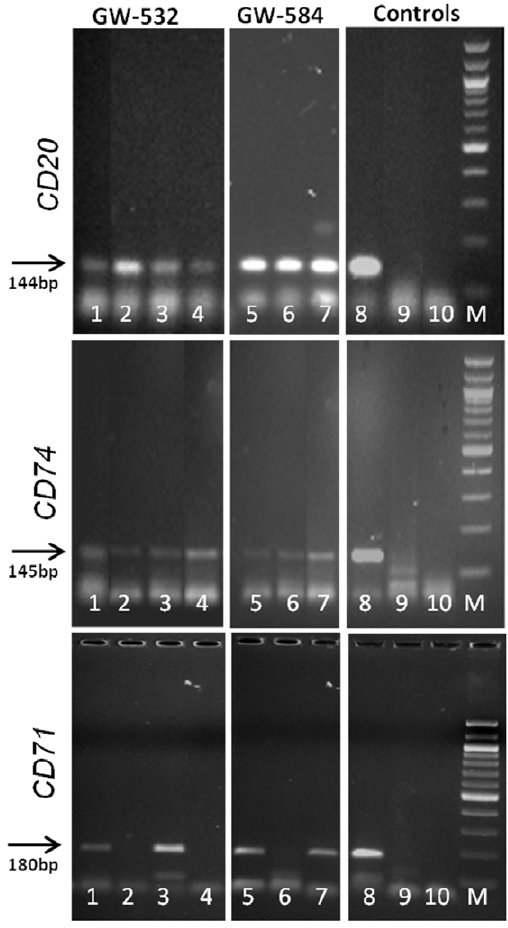
Figure 5. PCR evaluation of GW-532 and GW-584 for the presence of CD20 , CD74 , andCD71 genes. DNA was extracted from formalin-fixed, paraffin-embedded specimens to be used as templates for PCR amplification with primers, as described in Supporting Information Table S1. The individual panels demonstrate the presence or absence of each gene within several generations of xenografted tumors. For PCR of CD20 , the lanes contained GW-532 primary tumor (1), and xenograft tumors from generations 25 (2), 39 (3), and 115 (4); GW-584 xenografted tumors from generations 1 (5), 20 (6), and 57 (7); and controls Raji human lymphoma (8), CHO (Chinese hamster ovary) (9), and primers alone (10). Size markers are shown in lane M. Lanes are identical for PCR of CD74 . For PCR of CD71 , the lanes contained GW-532 xenografted tumors from generations 1 (1), 19 (2), 25 (3), and 115 (4); and GW-584 xenograft tumors from generations 1 (5), 20 (6), and 57 (7). Controls are identical to the CD20 and CD74 panels.